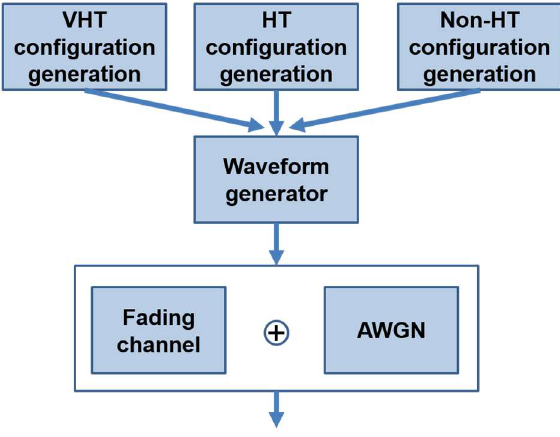
Figure 5. Transmitted / received (Tx / Rx) data generation.